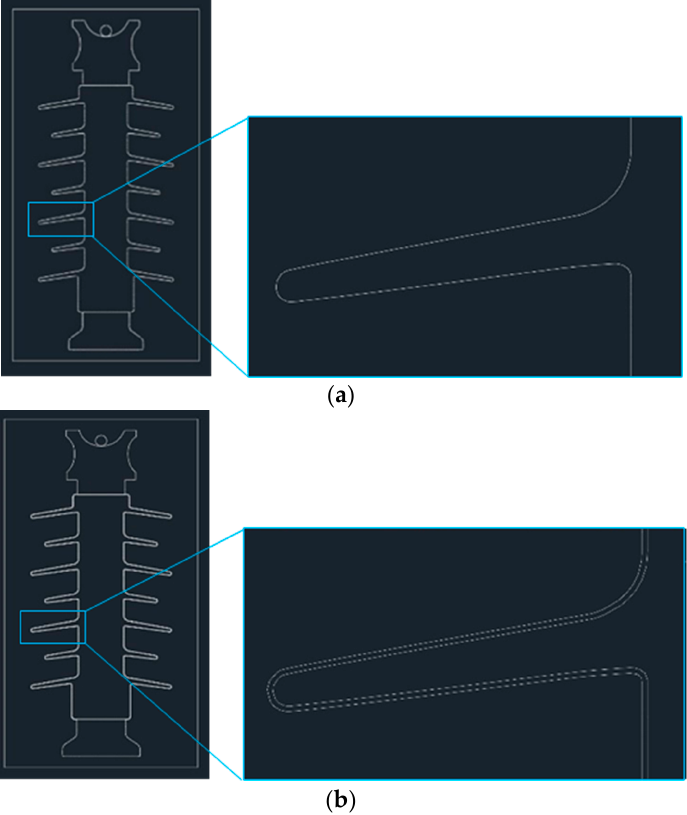
Figure 1. Polymer insulator design ( a ) without pollutant and ( b ) with pollutant. Insulator simulation using FEM-based software requires several parameters from the insulator constituent materials, live conductors, and air around the insulator to be simulated. The parameters required are relative permittivity and electrical conductivity (S/m). These parameters are shown in Table 2.